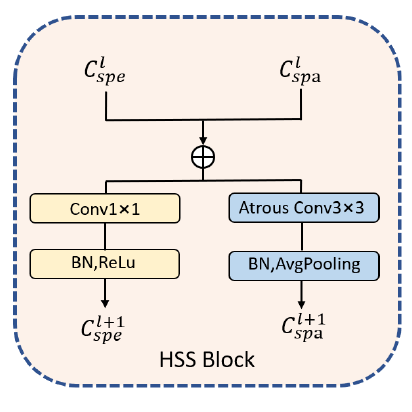
Figure 2. The structure of the HSS Block, where C l , k spe and C l , j spa are the k -th channel of the l -th spectral feature map and spatial feature map,